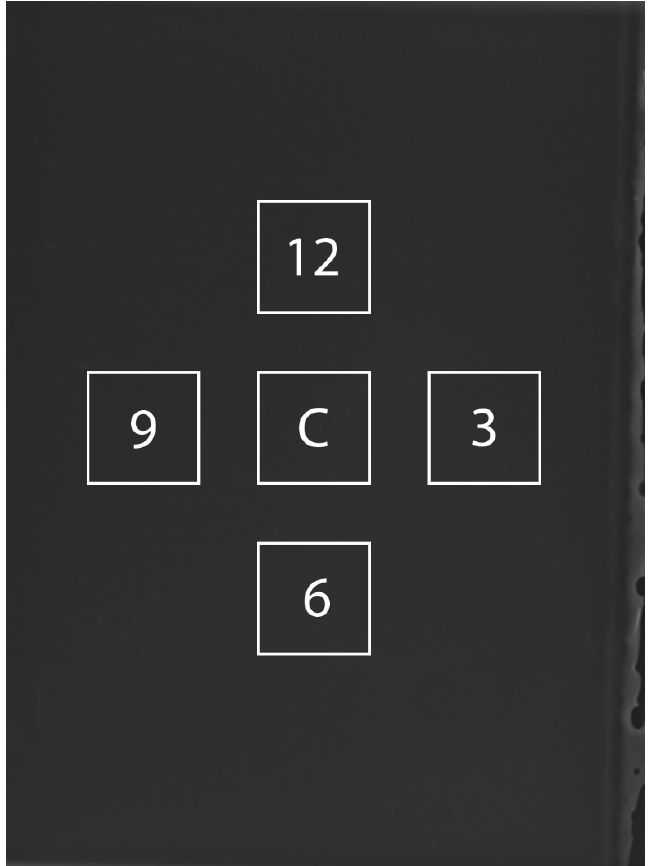
Figure 4. Illustration of film uniformity measurements. A square region of interest (ROI) of 100 × 100 pixels was placed at the image center. Additional ROIs were placed at radial positions of 3, 6, 9, and 12 o’clock. The center to center distance from each ROI is approximately 1 cm. Care was taken to avoid making radial measurements too close to the edge of the image.